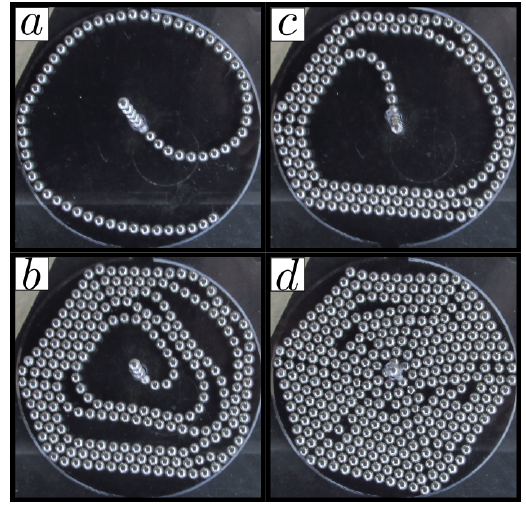
Figure 4. Four snapshots taken during the filling of the cavity. Here a chain of magnetic beads is injected into the cavity into the center from the bottom.